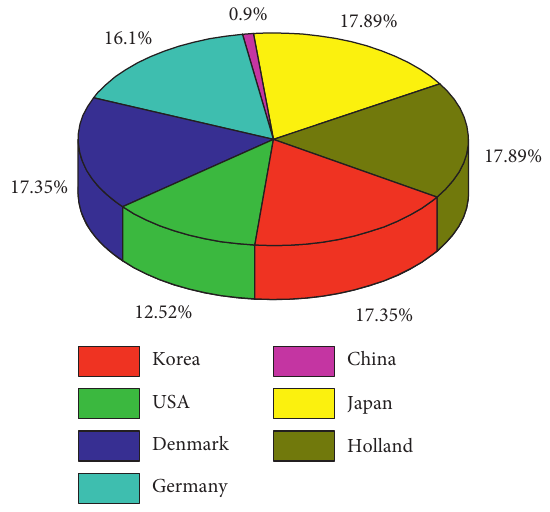
Figure 1: Construction waste utilization rate (year